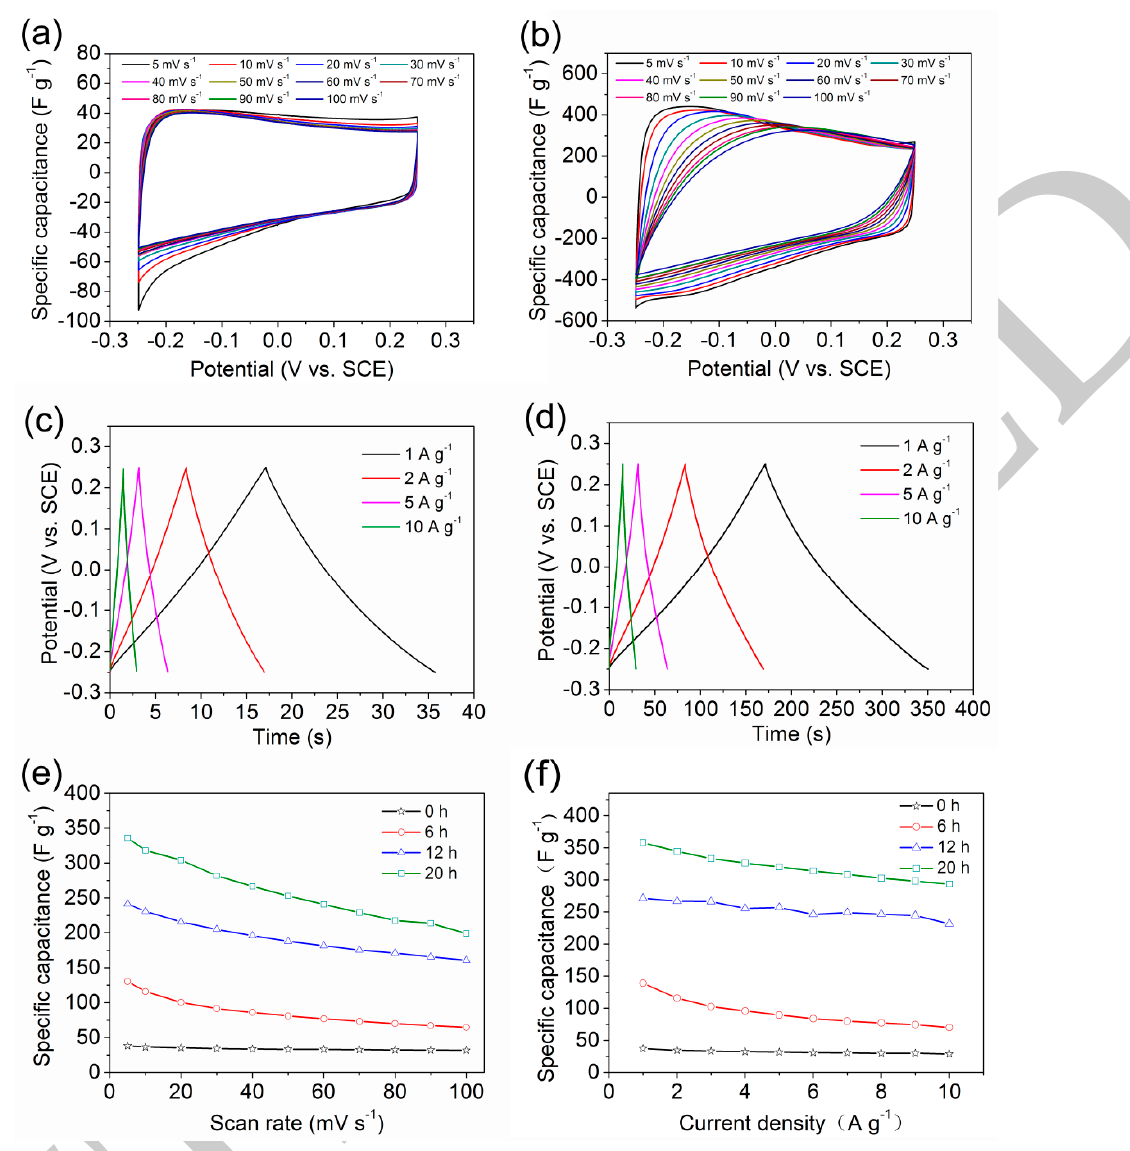
Figure 8. CV profiles of ( a ) Ti 3 C 2 T x and ( b ) 20 h N-TiO 2 / TiN / Ti 3 C 2 T x at di ff erent scan rates. The GCD curves for ( c ) Ti 3 C 2 T x and ( d ) 20 h N-TiO 2 / TiN / Ti 3 C 2 Tx at current densities of 1, 2, 5, and 10 A g − 1 . ( e ) Gravimetric specific capacitances at di ff erent scan rates. ( f ) Gravimetric specific capacitances at di ff erent current densities of Ti 3 C 2 T x , 6 h, 12 h and 20 h N-TiO 2 / TiN / Ti 3 C 2 T x